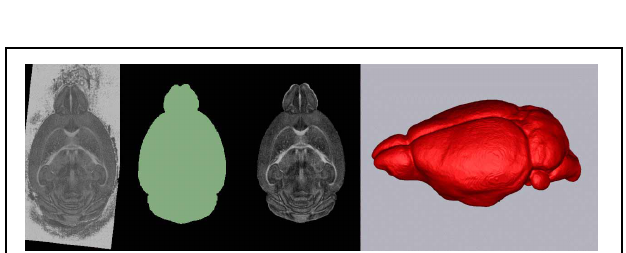
FIGURE 7 | Skull-stripping pipeline. From left to right: original FA image, computed mask, original FA image skull-stripped, 3D rendering of computed mask.